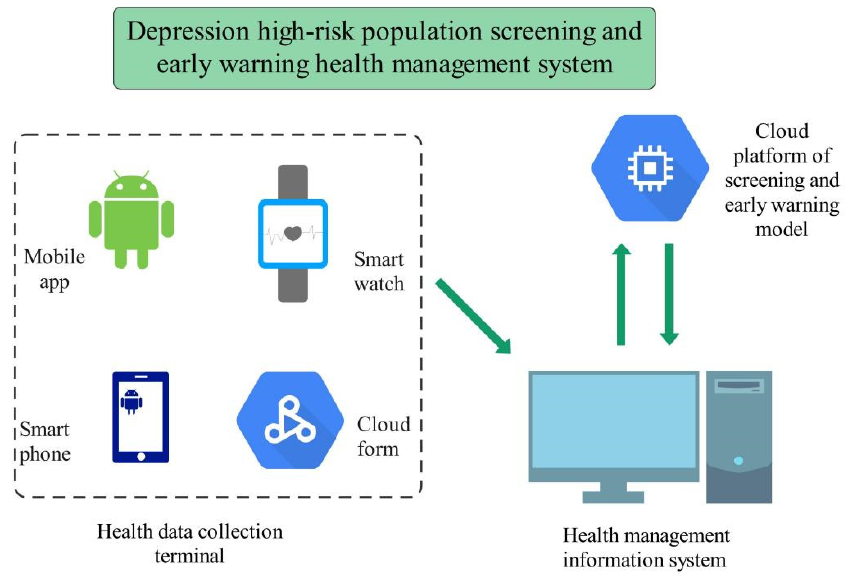
Figure 3. Design scheme of the screening and early warning health management system for popu- lations at high risk for depression.